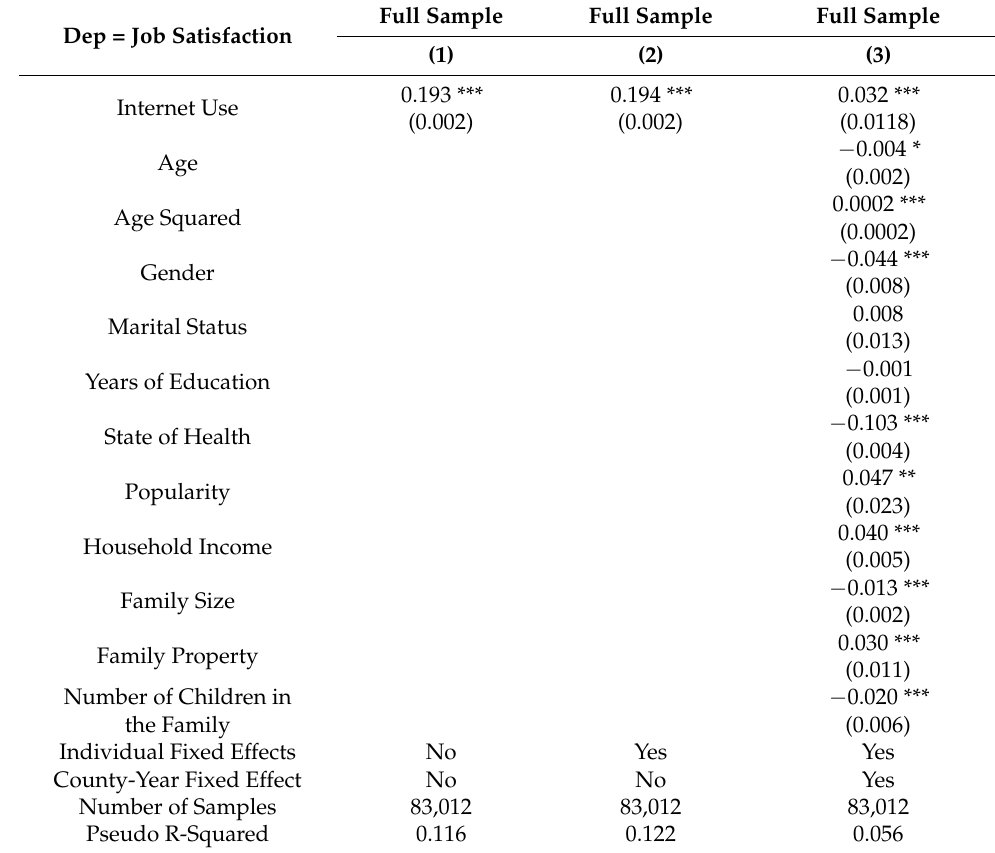
Table 2. Ordered Logit Estimates of Internet Use and Job